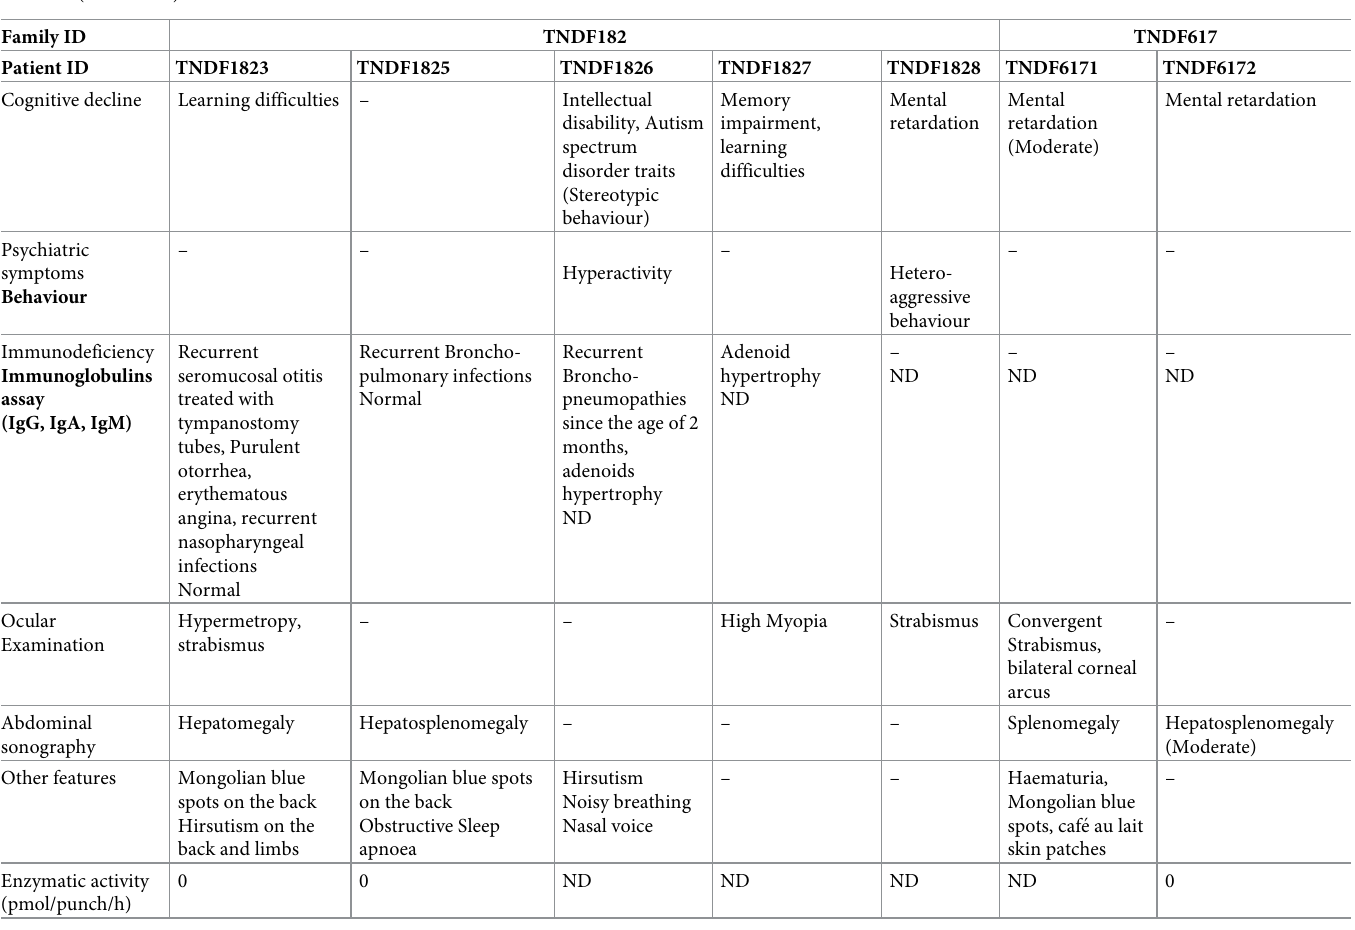
Table 1 summarizes the results of the clinical investigation of all the patients enrolled in the current study. †Not